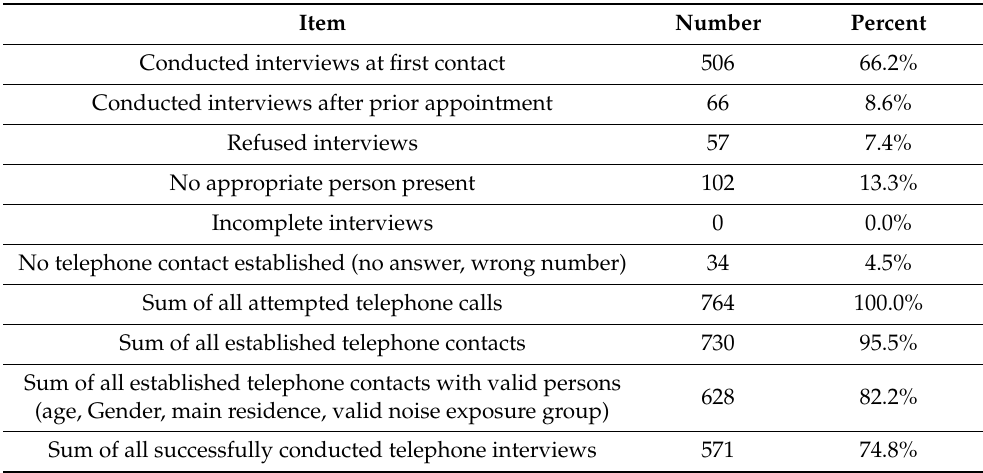
Table 1. Response rates in the noise clusters of strong, medium and little a ff ected address points.